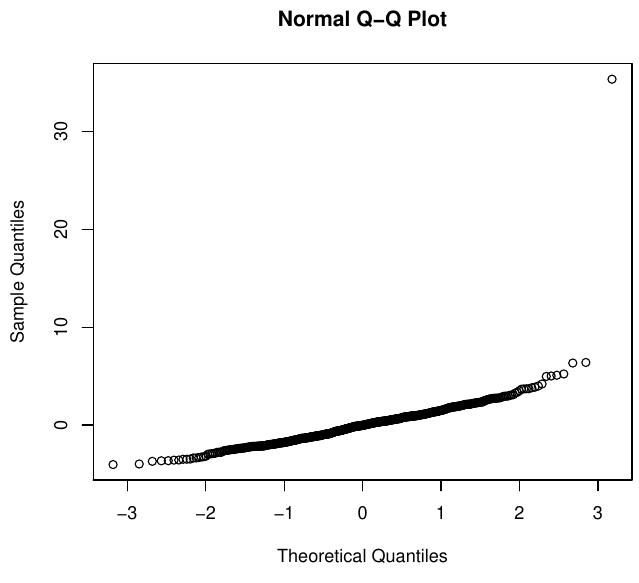
Figure 2. Q-Q plot for the OLS